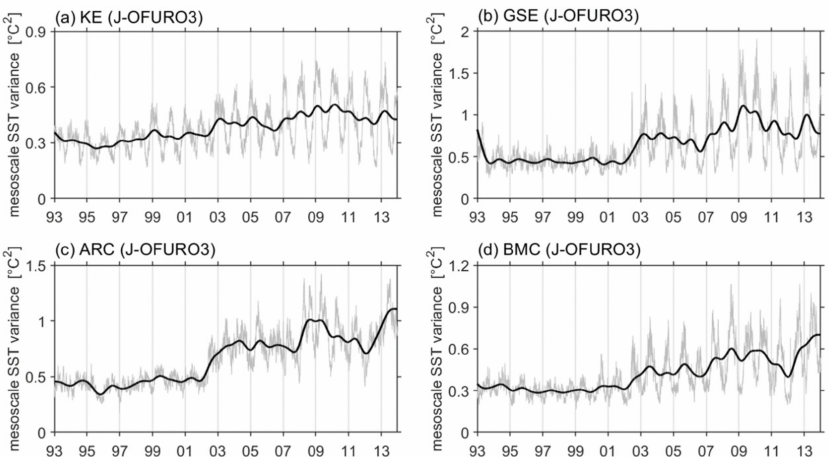
Figure 12. Time series of the mesoscale SST variance based on the J-OFURO3 data in the regions of ( a ) KE, ( b ) GSE, ( c ) ARC, and ( d ) BMC. The thin and thick lines denote the daily and 1.5-year low-pass filtered time series, respectively.